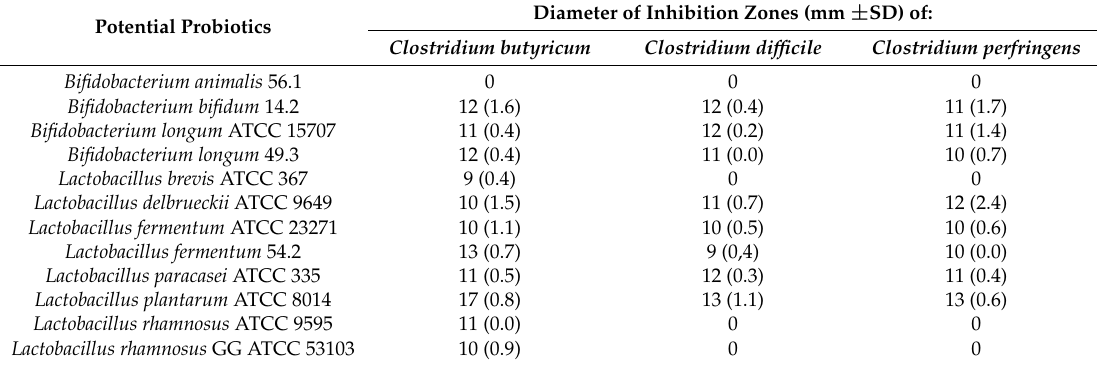
Table 1. Inhibitory activity of Bifidobacterium and Lactobacillus against Clostridium spp. based on the agar spot